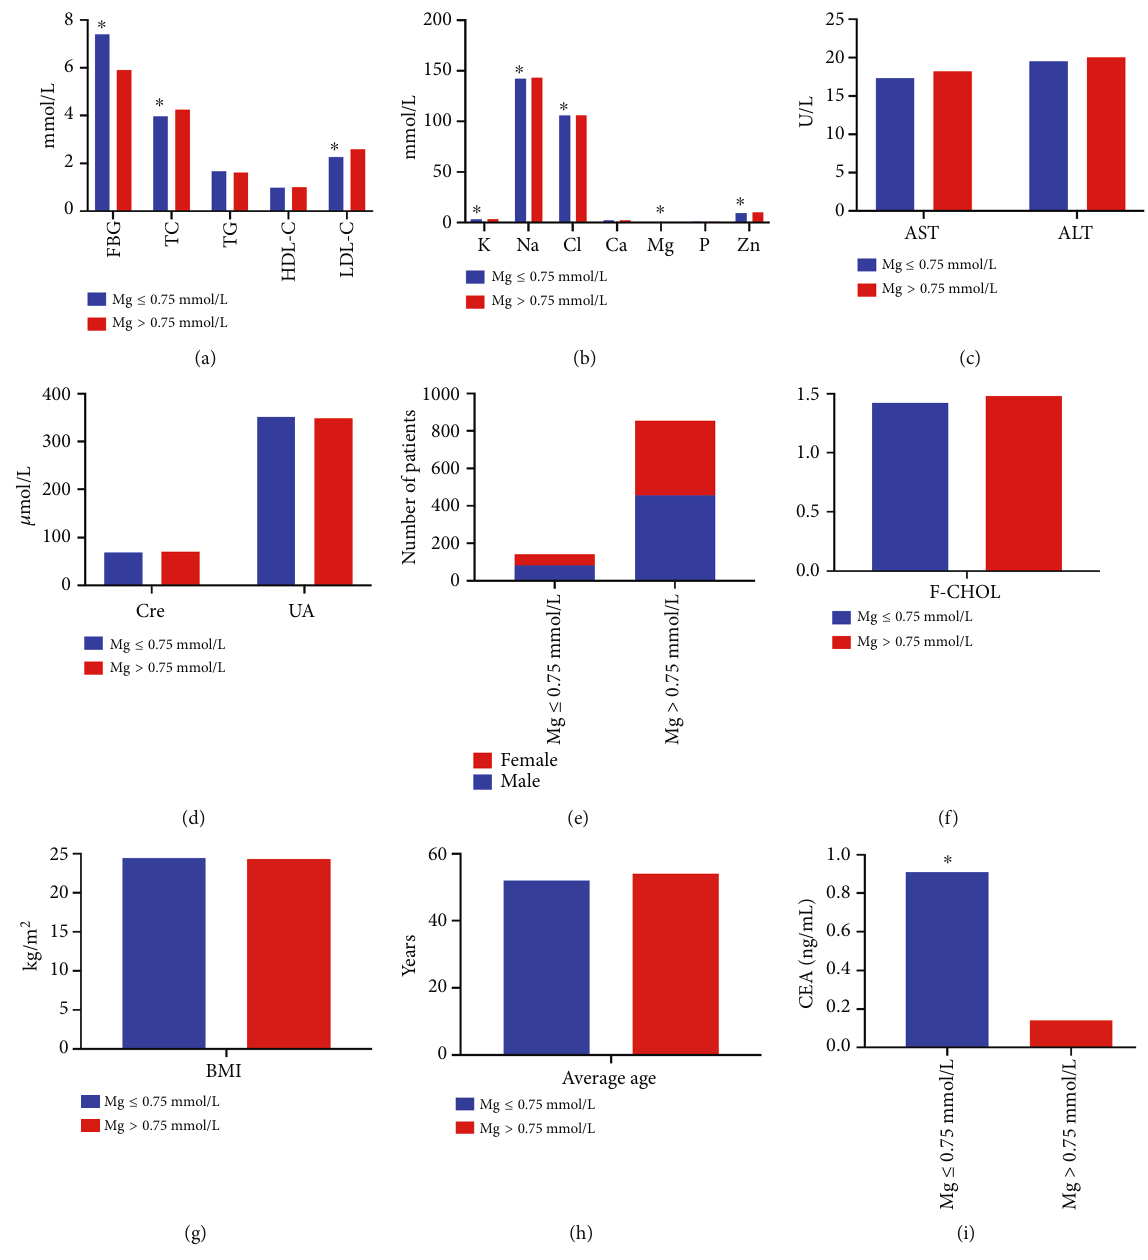
Figure 9: Comparison of di ff erent indicators between the Mg ≤ 0 : 75mmol/L and Mg > 0 : 75 mmol/L groups. (a) Comparison of levels of FBG, TC, TG, HDL-C, and LDL-C between the two groups. Compared with the Mg > 0 : 75 mmol/L group, the levels of FBG and TC were signi fi cantly higher but LDL-C was lower in Mg ≤ 0 : 75 mmol/L group. (b) Comparison of levels of K, Na, Cl, Ca, Mg, P, and Zn in the blood between the two groups. (c) Comparison of AST and ALT levels between the groups. (d) Comparison of Cre and UA levels between the groups. (e) Comparison of the number of male and female patients between the groups. (f) Comparison of F-CHOL between the groups. (g) Comparison of BMI of patients between the groups. (h) Comparison of the average age of patients between the groups. (i) The blood CEA in Mg ≤ 0 : 75 mmol/L group was signi fi cantly higher than in Mg > 0 : 75 mmol/L